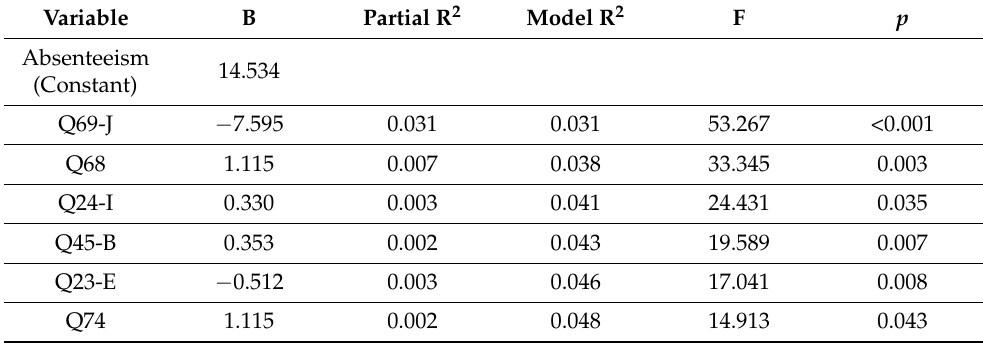
Table 4. Factors that affect